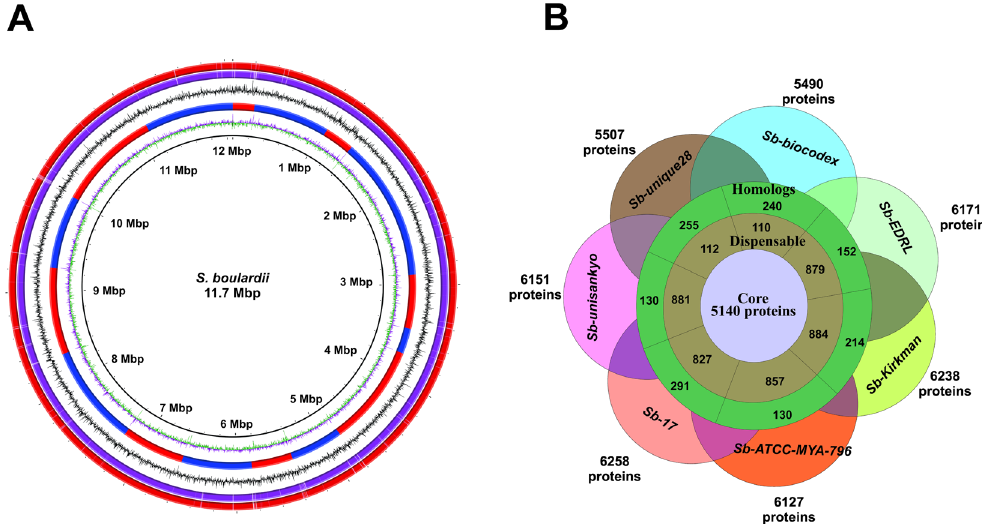
Figure 1. ( A ) Circular representation of the Sb - biocodex and Sb - unique28 complete genome. Circles (from inside to outside): circle 1 (GC content), circle 2 ( Sc S288C complete chromosomes with alternative blue and red color); circle 3 (GC skew); circle 4 ( Sb - biocodex complete chromosomes); circle 5 ( Sb - unique28 complete chromosomes). BRIG 0.95 was used to build the circular representation. Mapping studies were done using BLASTn with an E-value cut-off 1e-5. ( B ) Core orthologous proteins among all Sb proteome represented by orthology diagram depicting dispensable proteome and homologs among these strains.